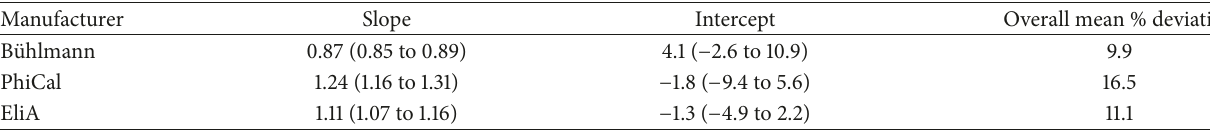
Table 3: The linearity of